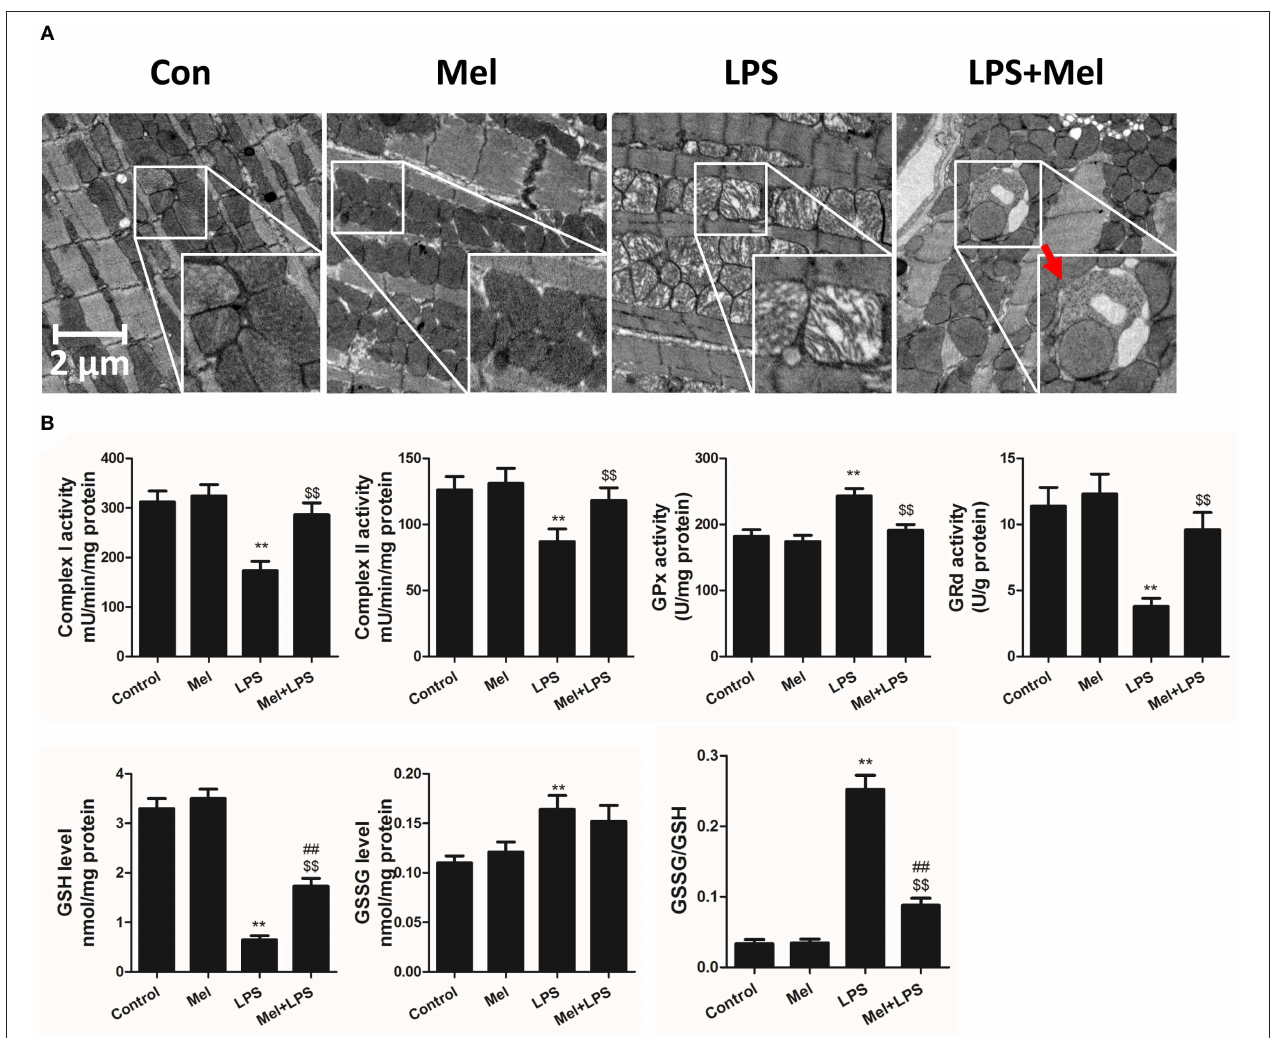
FIGURE 3 | Effects of melatonin administration on mitochondrial ultrastructure and function after LPS injury. (A) Representative images of mitochondrial morphology. The red arrow indicates an autophagosome. (B) Quantitative analysis of mitochondrial Complex I, Complex II, GPx, and GPd activity, and GSH, GSSG levels. n = 6 ** P < 0.05 vs. the control group, ## P < 0.05 vs. the Mel group, $$ P < 0.05 vs. the LPS group. Mel,